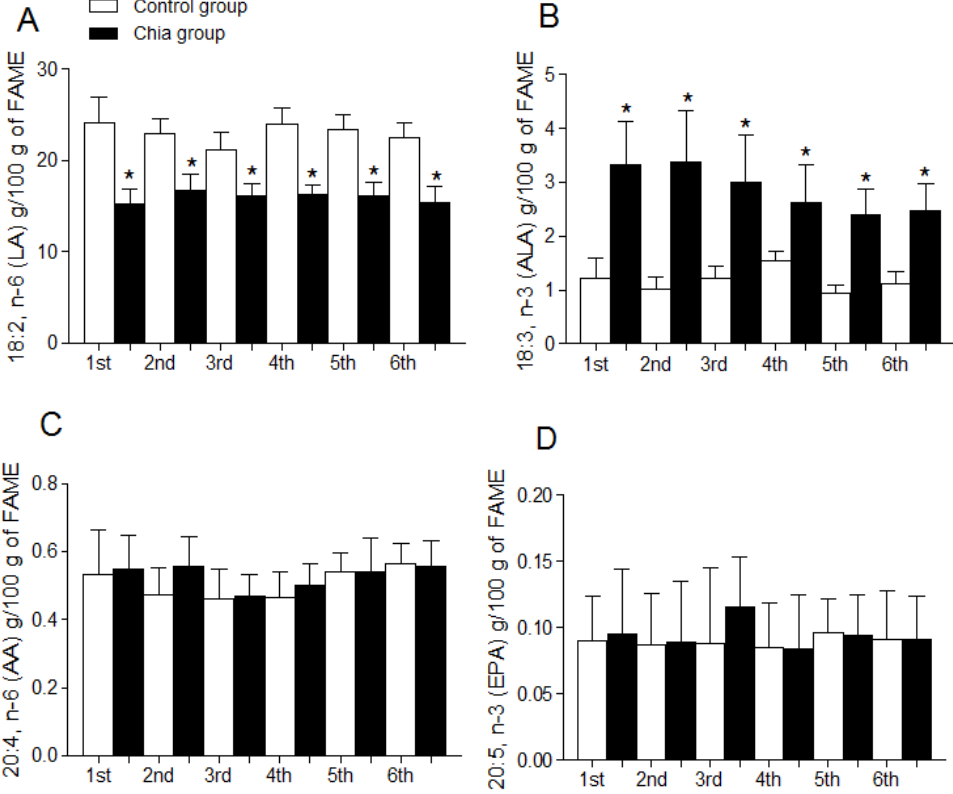
Figure 2. Cont Figure 2. Cont. Figure 2. Cont.